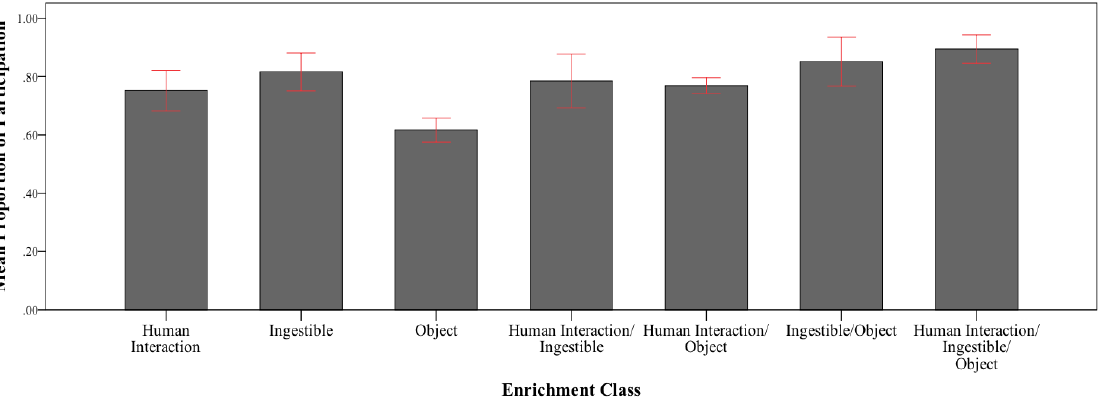
Figure 1. Mean (±2 SE) proportion of subjects ( n = 19) that participated with each enrichment class, including all trials and subjects. A lower proportion of animals participated with Object enrichment compared to Ingestible ( p < 0.01), Human Interaction/Object ( p < 0.01), Ingestible/Object ( p < 0.001) and Human Interaction/Ingestible/Object ( p < 0.001)